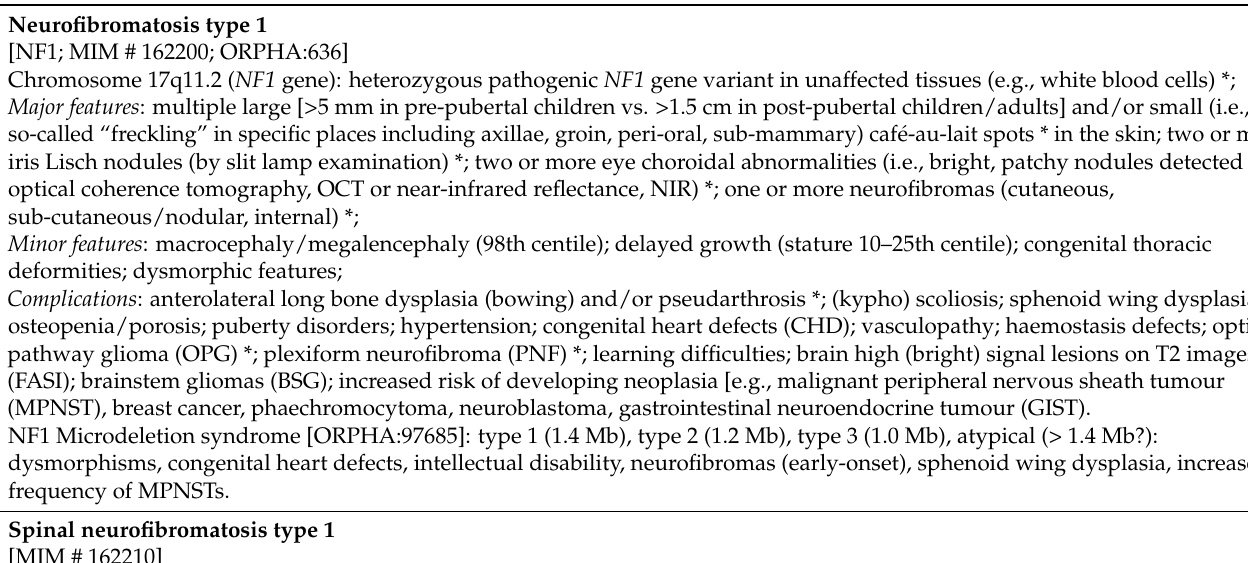
Table 2. Neurofibromatosis type 1 and related/alternative disorders: clinical phenotypes and genotypes. Neurofibromatosis type